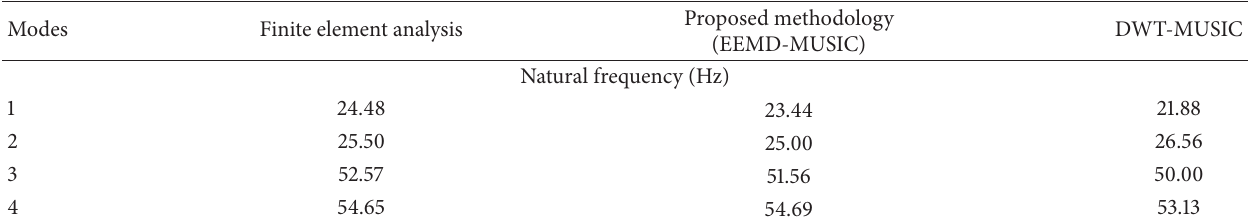
Table 2: Comparison of natural